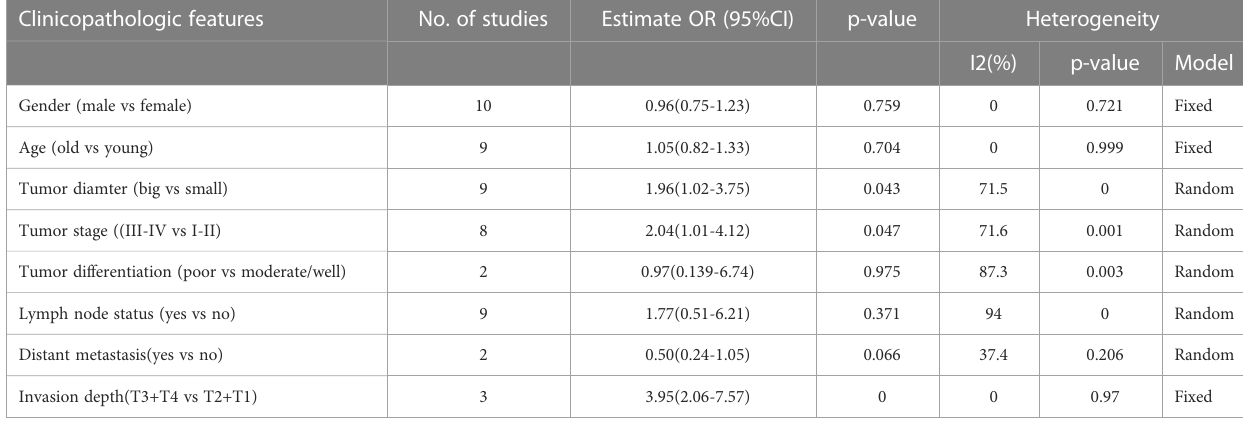
TABLE 3 Association between high Nectin-4 expression and clinicopathological features. Clinicopathologic